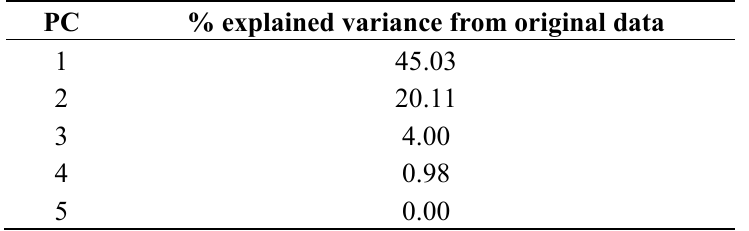
Table 3. Results of CPCA analyses of anti- Cryptococcus